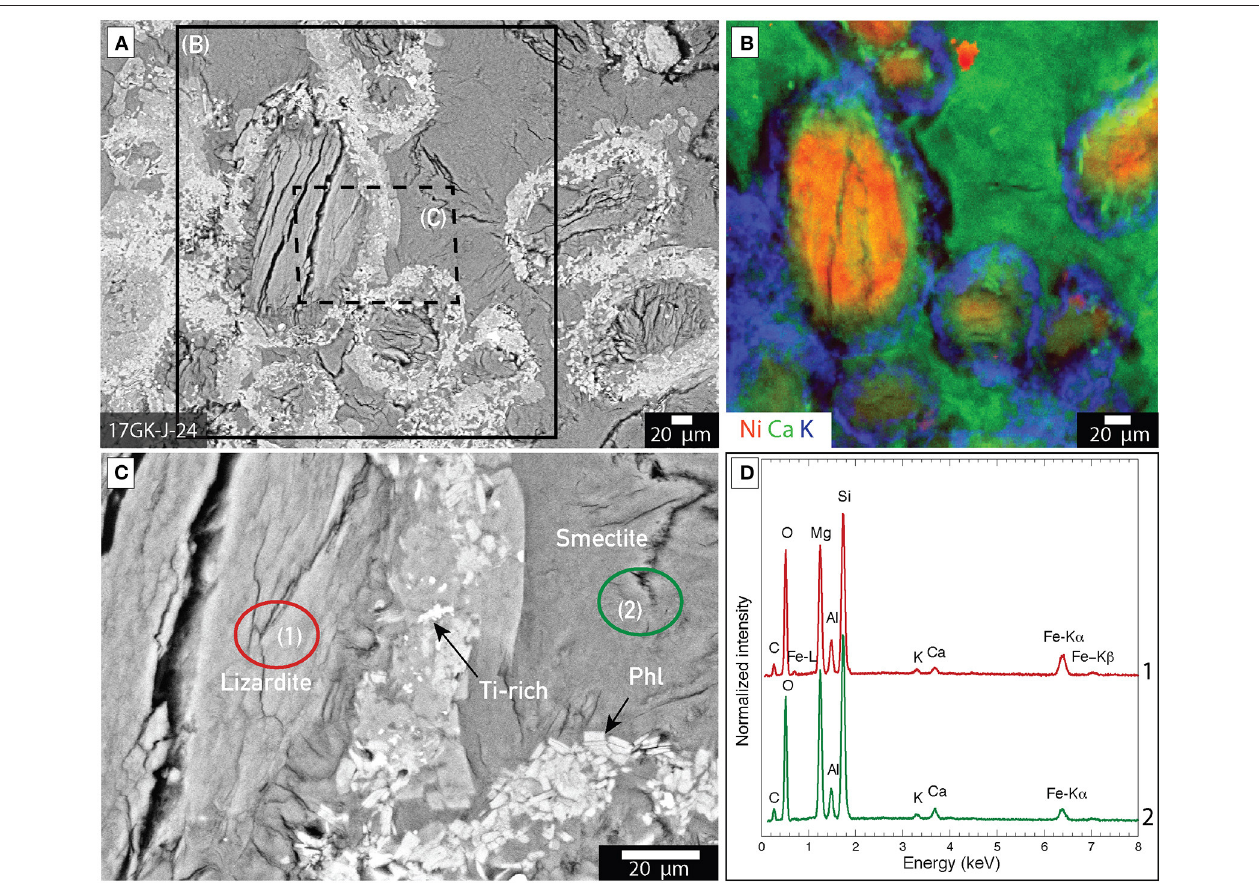
FIGURE 6 | Distribution of mineral phases within kimberlite ores from Gahcho Kué (17GK-J-24). (A) Backscattered electron image of a petrographic thick section showing lizardite grains (after forsterite) surrounded by bright rims and a smectite matrix; (B) XFM map of Ni (red), Ca (green) and K (blue) of the area marked by a solid rectangle in (A) . The red, green and blue colors correspond to the measured intensities of the Ni K-alpha, Ca K-alpha and K K-alpha emission lines, with the brightest color, the highest measured count rate and black corresponding to the lowest count rate; (C) Close up corresponding to the dashed rectangle in (A) showing that the rim is composed of talc, Ti-rich grains (Ti), likely ilmenite, and phlogopite (Phl); (D) SEM-EDXS spectrum of the circled area in (B)